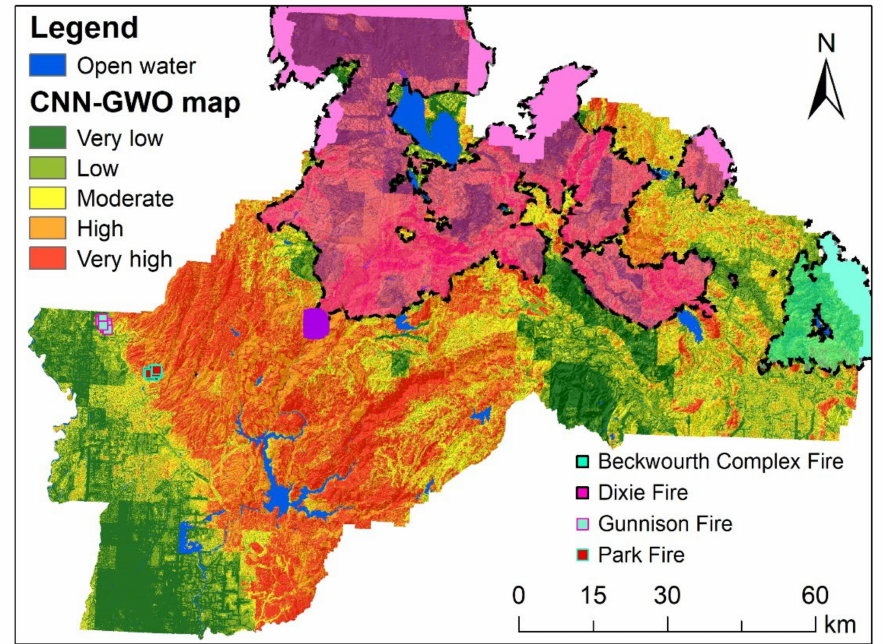
Figure 11. Comparison of the CNN-GWO model with wildfires that occurred in